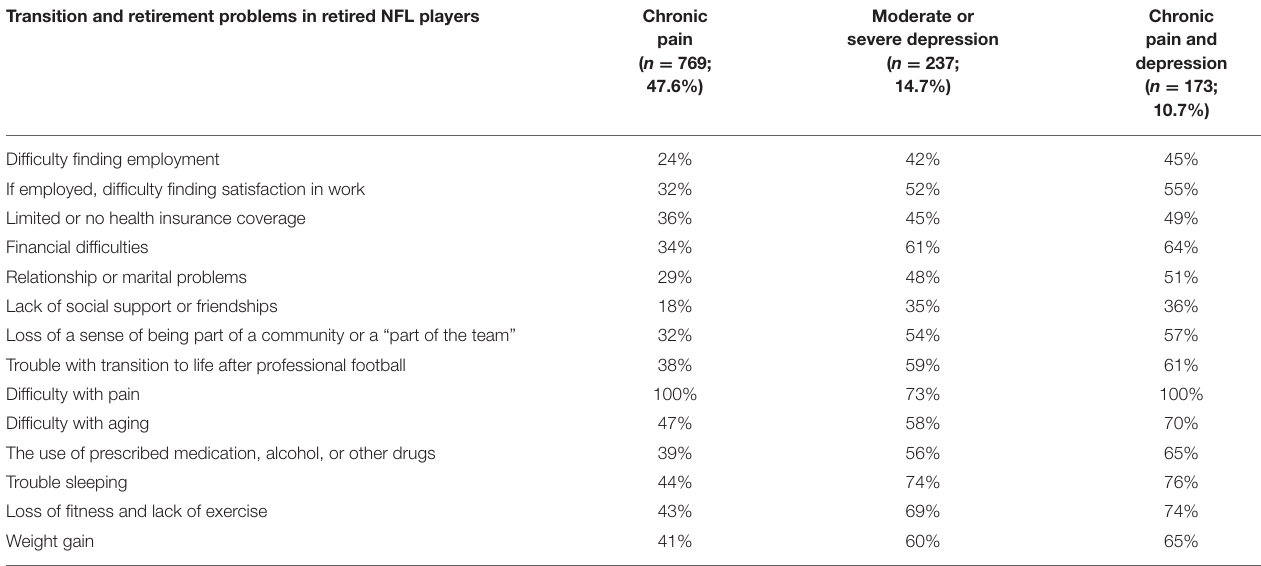
TABLE 1 | Transition and retirement problems in NFL players with chronic pain and